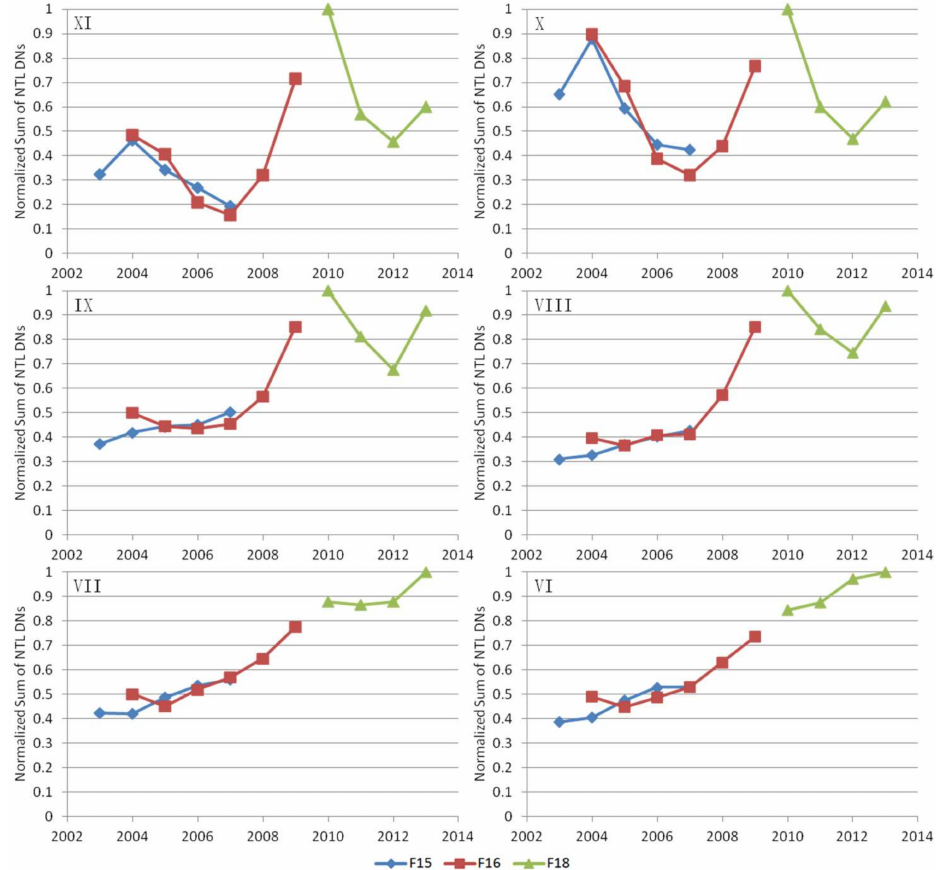
Figure 7. The changing trends in normalized sum of NTL in regions with different seismic